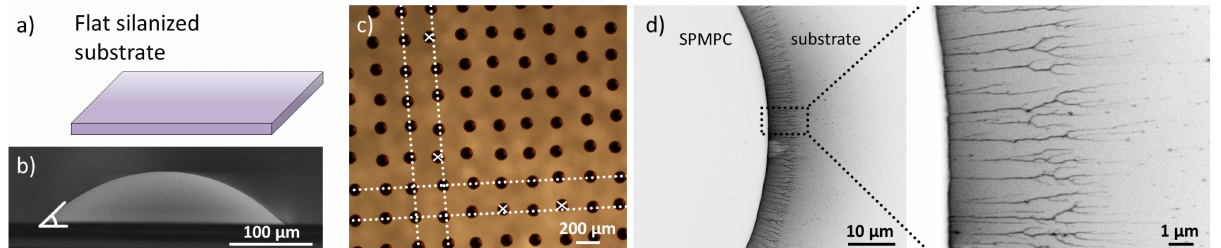
Figure 3. Inkjet printed spherical structures onto silanized flat substrate ( a ) schematics and ( b ) SEM side view of a printed drop with a typical contact angle after curing of 46.5°. ( c ) Top view optical images showing a printed array; their misalignment—resulting from their random pinning line receding—is highlighted by the white straight lines, and the crosses point out the misaligned structures. ( d ) Top view SEM images of the edge of one printed structure and zoom showing traces of nanoparticle (NP) agglomerates (on silicon substrate for imaging reasons with the same surface